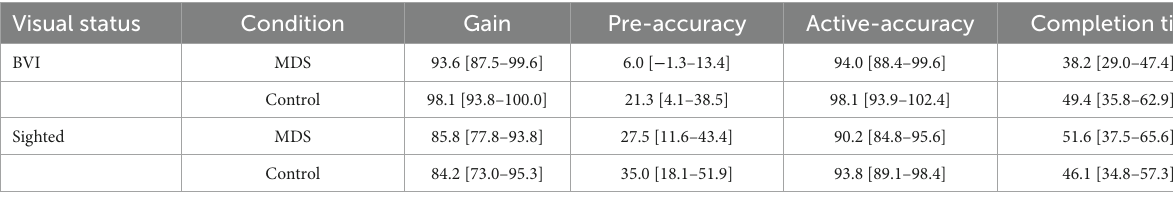
TABLE 8 Summary of pre/post accuracy collapsed across diagram.